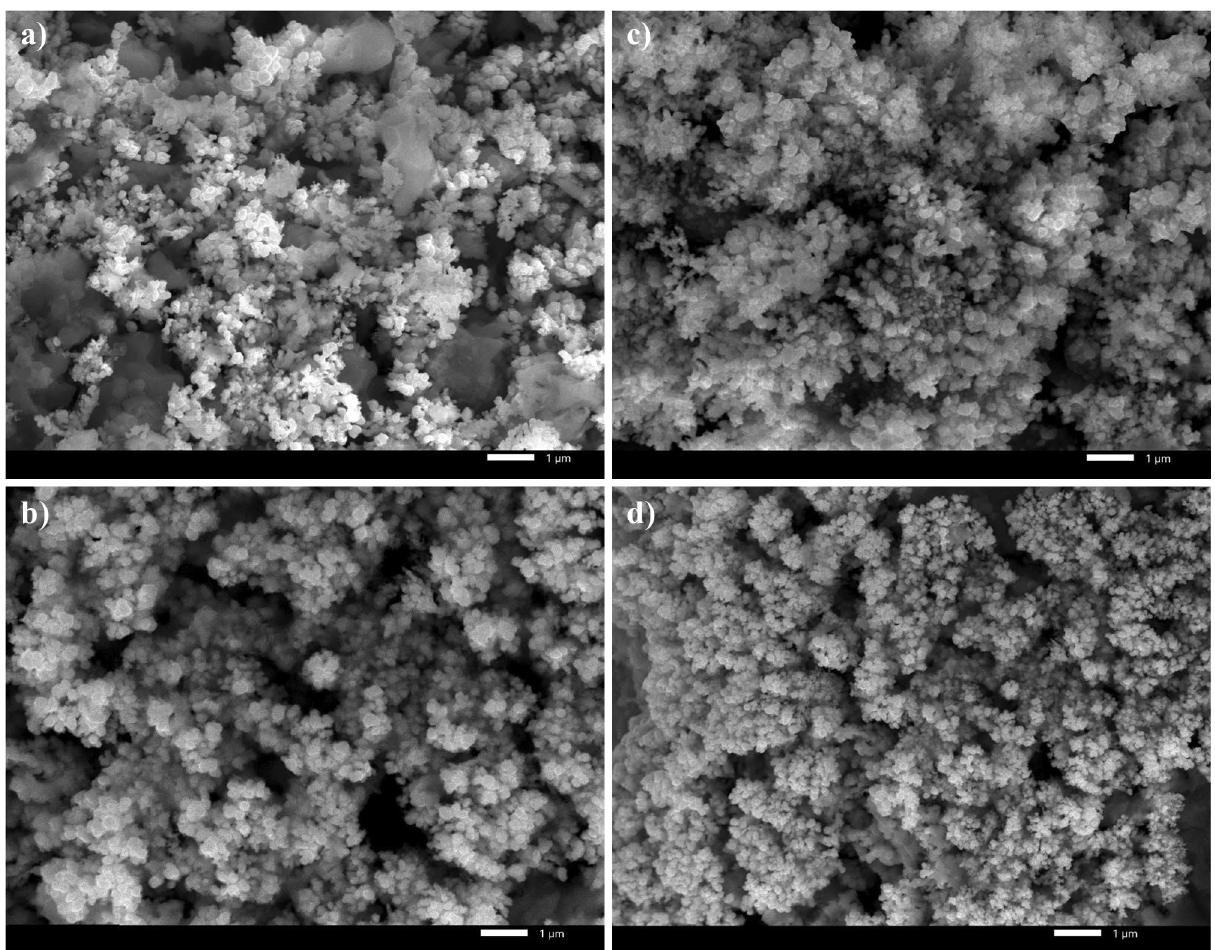
Figure 4. SEM micrographs of coated steel by ( a ) Ni@G, ( b ) Ni@G@MA, ( c ) Ni@Cr-G, and ( d ) Ni@Cr-G@